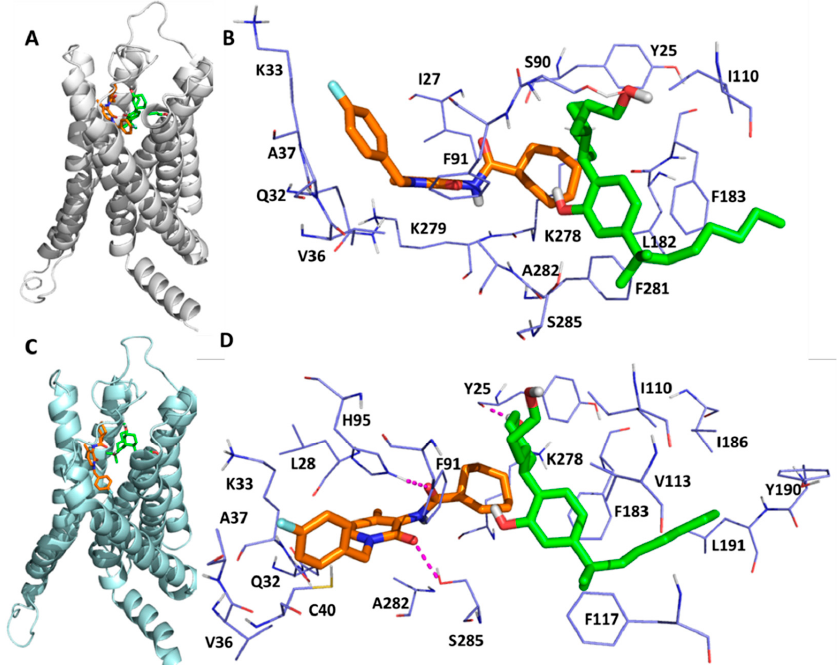
Figure 9. The detailed interactions between C-2, CP55940 and CB2 receptor where C-2 resides in site H. ( A ) The crystal structure of CP55940/CB2 with C-2, the PAM binding at site H. ( B ) The CB2 residues surrounding CP55940 and C-2. ( C ) The representative MD structure (the one that is structurally most similar to the average structure). ( D ) The residues surrounding CP55940 and C-2 in the representative MD structure. Two hydrogen bonds are formed between C-2 and CB2 residues (H95 2.65 and S285 7.38 ), and one hydrogen bond is formed between CP55940 and Y25. The hydrogen bonds are shown as magenta dashed